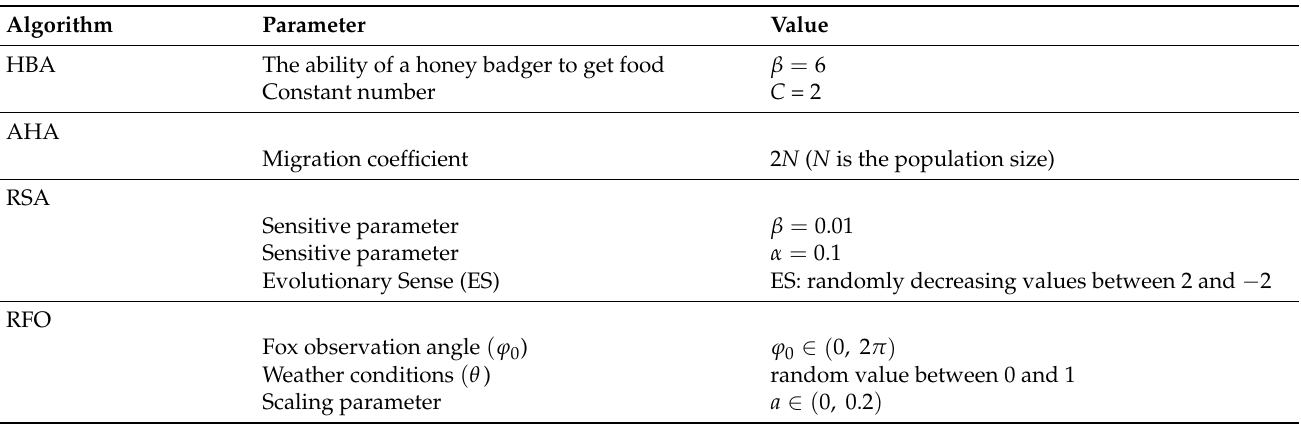
Table 1. Parameter values for the compared algorithms.